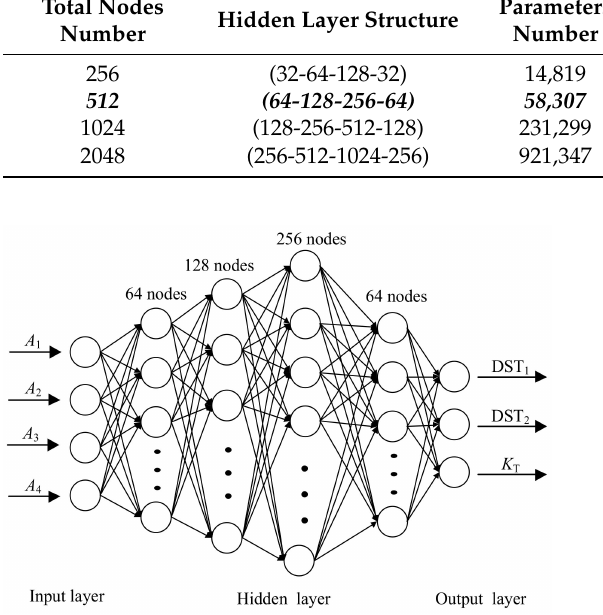
Figure 6. Structure of the neural network used in the surrogate